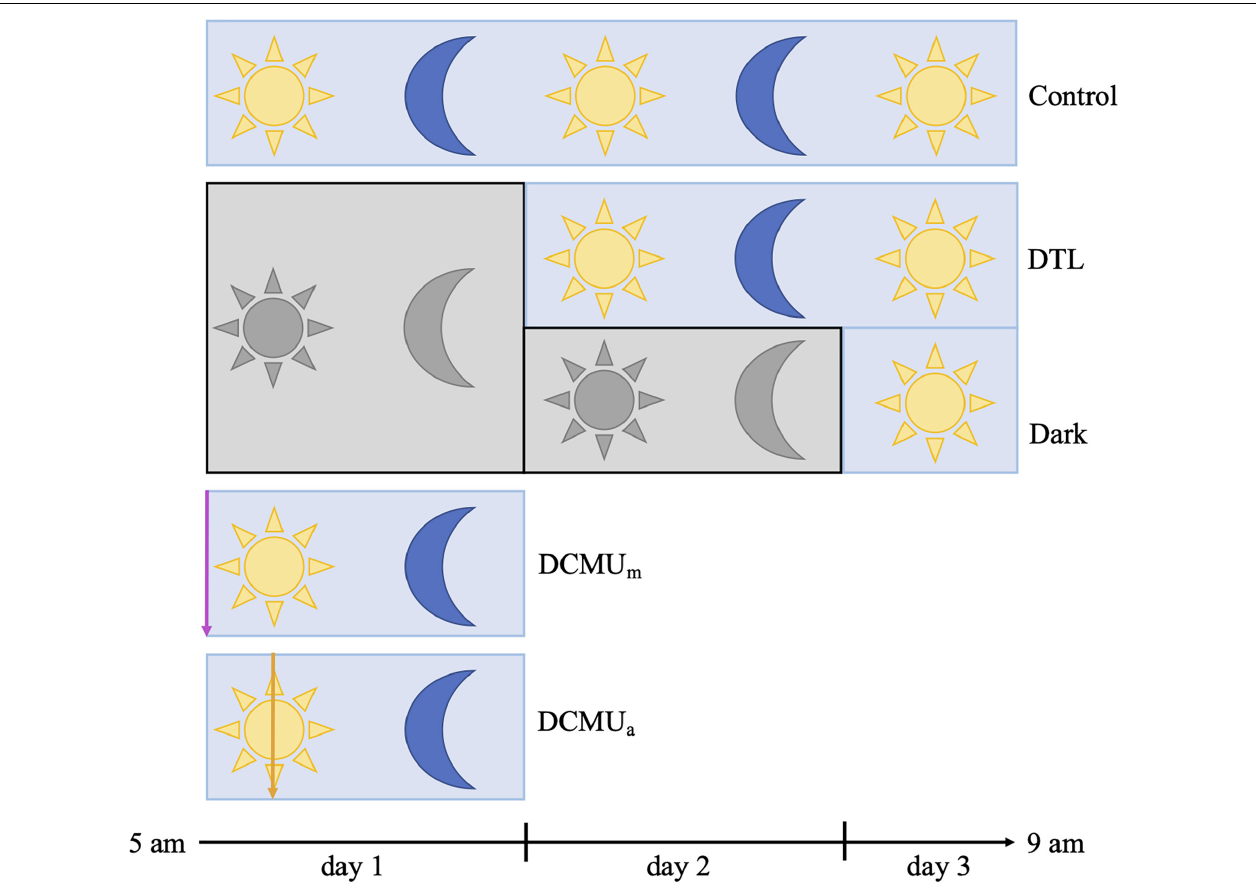
FIGURE 1 | Schematic representation of experimental conditions. Blue rectangles represent clear incubators and gray rectangles represent opaque incubators. Yellow sun and blue moon represent normal light-dark conditions achieved with clear incubators, and gray sun and moon represent complete darkness achieved with opaque incubators. In the two conditions involving a dark phase, bottles were placed in opaque incubators at the beginning of the experiment and then moved to clear incubators at 5 a.m. on day 2 (“Dark then light”, DTL) or on day 3 (Dark). For incubations receiving DCMU, the purple arrow represents DCMU addition before 5 a.m. (DCMU m ) and the orange arrow represents DCMU addition at 1 p.m. (DCMU a ). See section “Materials and Methods” for additional description of incubation and sampling